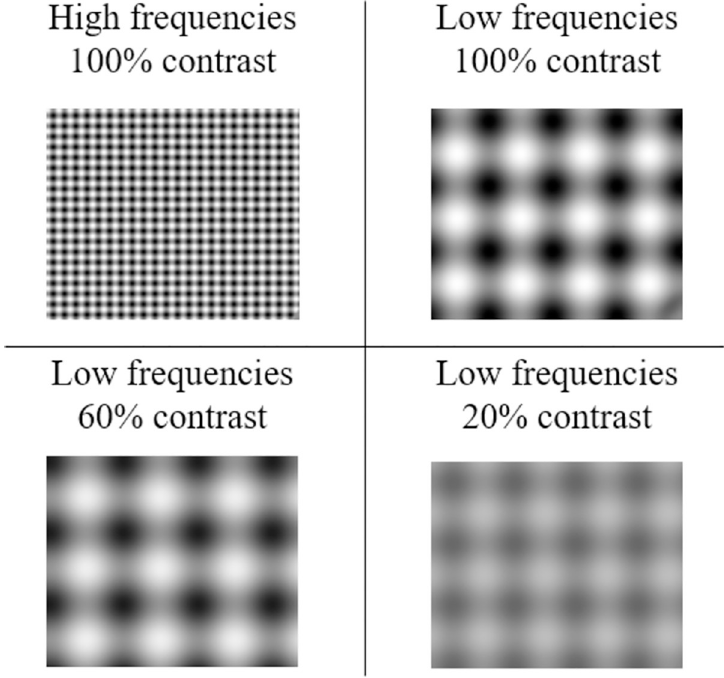
size (0.48˚) and with 100% contrast; the goal was to ensure that their identification was only dependent on the display (binocular vs monocular). They were presented in four directions of aperture (i.e., opening to the left, right, up, or down), at two eccentricities (0.81˚ and 2.00˚